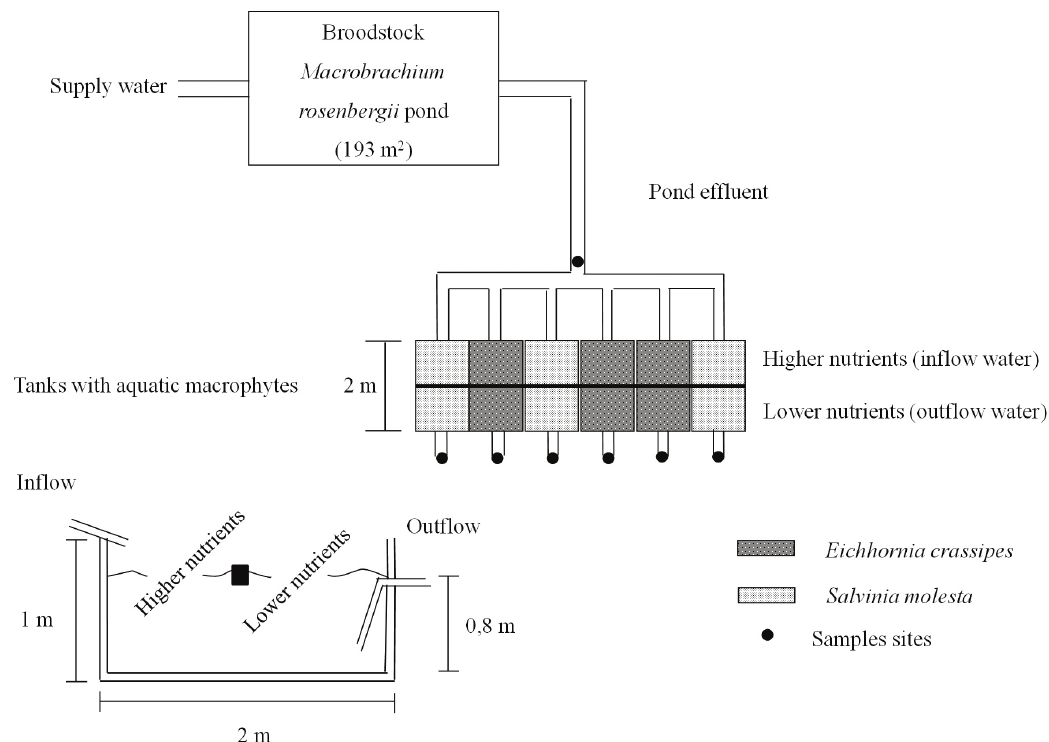
Figure 1. Schematic diagram of the experiment with free-floating aquatic macrophytes grown under different nitrogen and phosphorus